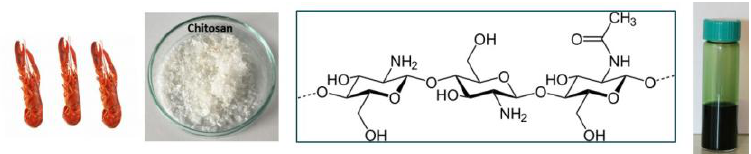
Figure 3. Chitosan and PANI-Chitosan